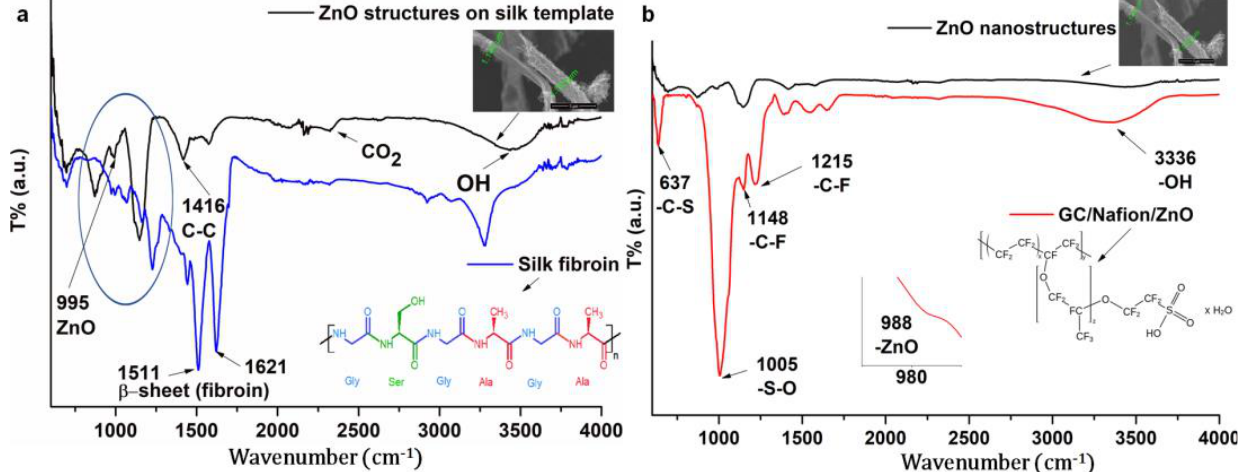
Figure 2. FT-IR spectra: ( a ) comparison between SF and ZnO structures on SF template and ( b ) comparison between ZnO nanostructures and GC/Nafion/ZnO 6.